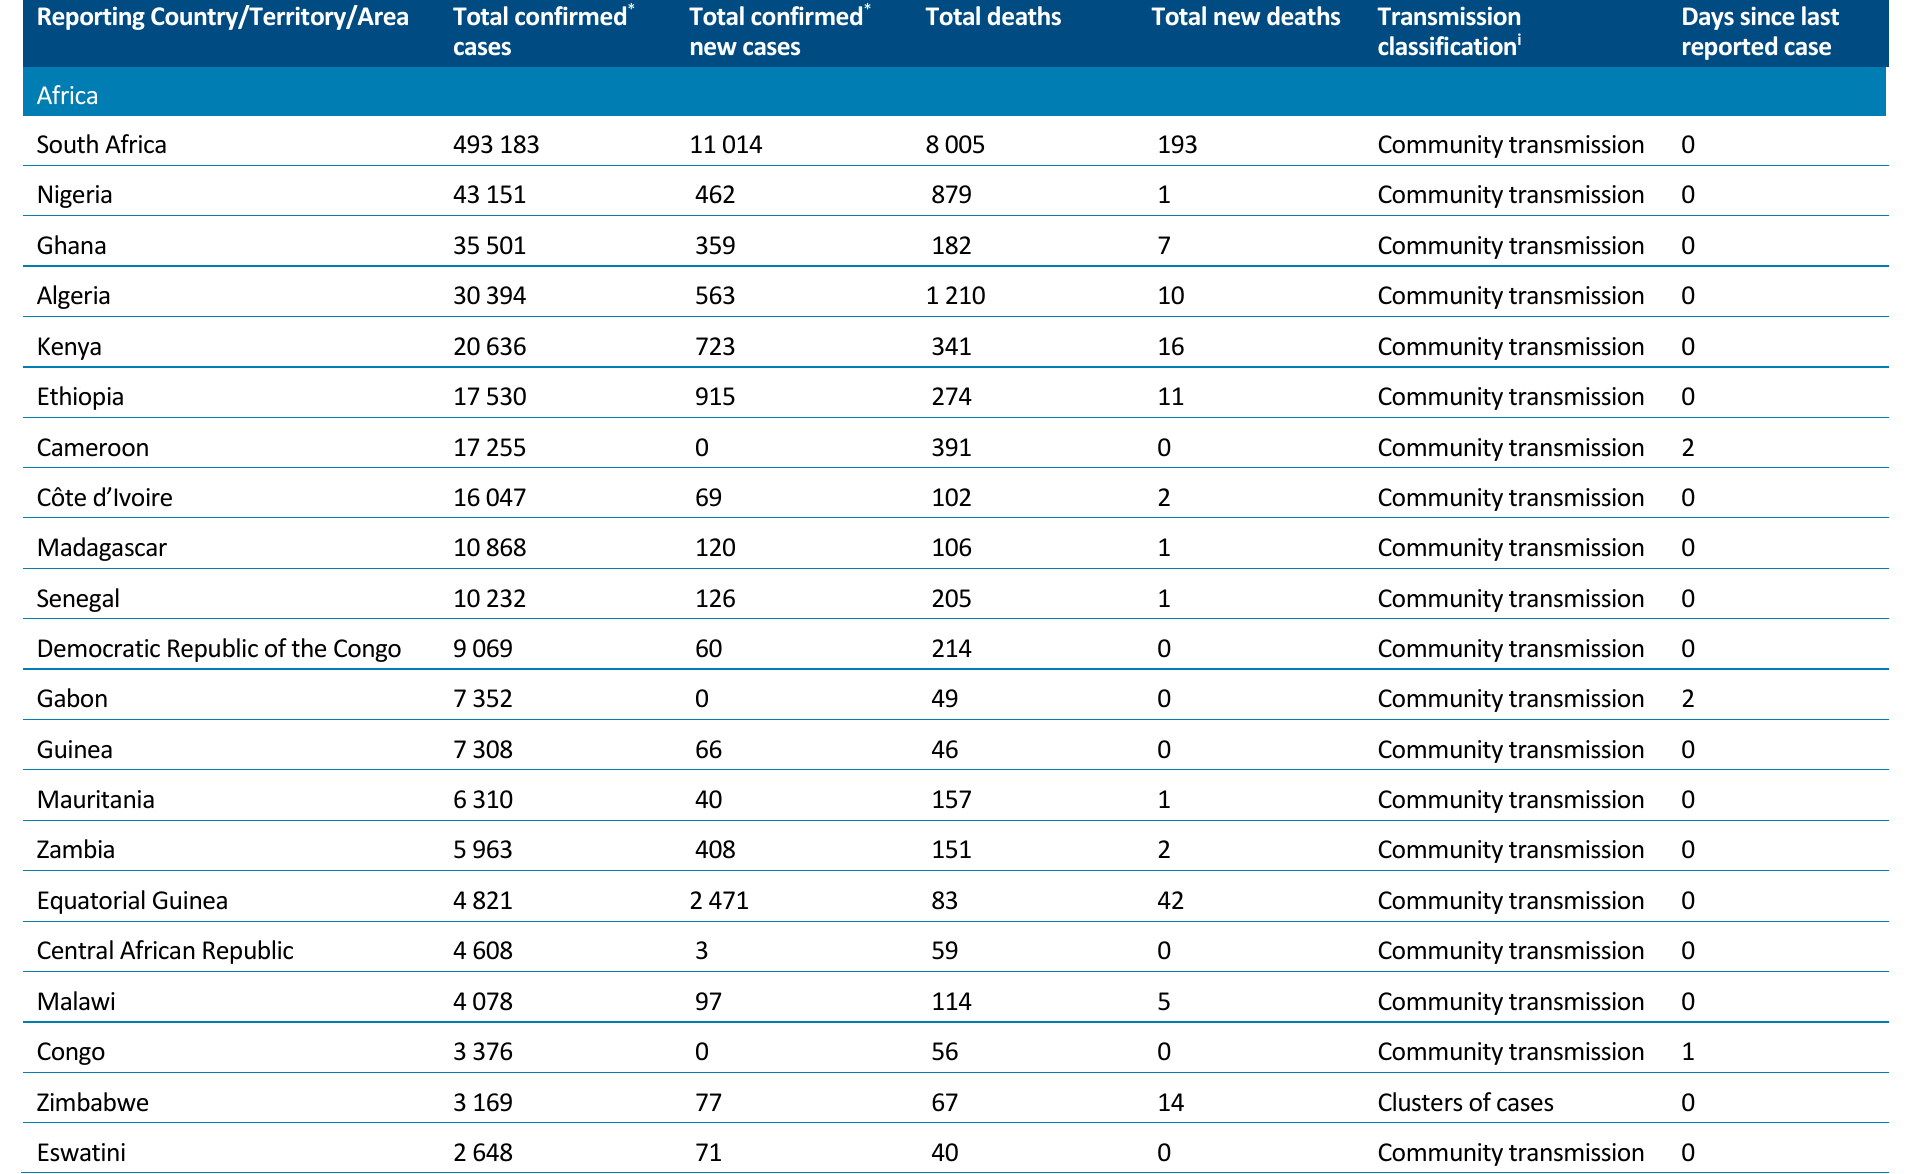
Table 1. Countries, territories or areas with reported laboratory-confirmed * COVID-19 cases and deaths, by WHO region. Data as of 10 AM CEST, 1 August 2020** Reporting